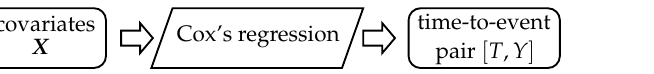
Figure 3. A logic of prediction based on the Cox proportional hazard model. Covariates X = ) T on input are used for the Cox model building, which enables us to estimate output, ( X 1 , X 2 , . . . , X k i.e., how likely the event of interest’s occurrence Y is in time T (and for specific values of other covariates X